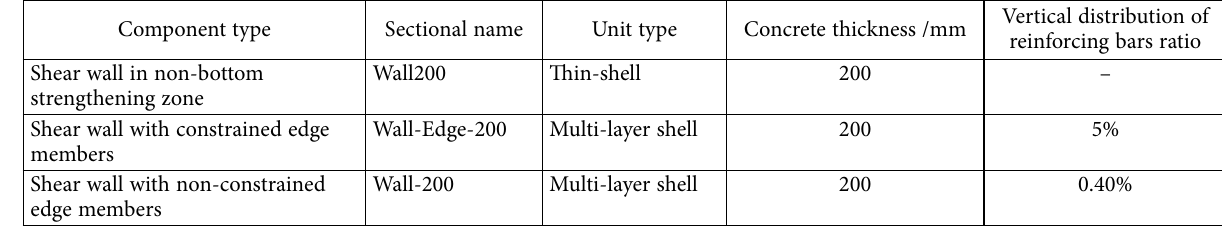
Table 2. Information of shear wall section